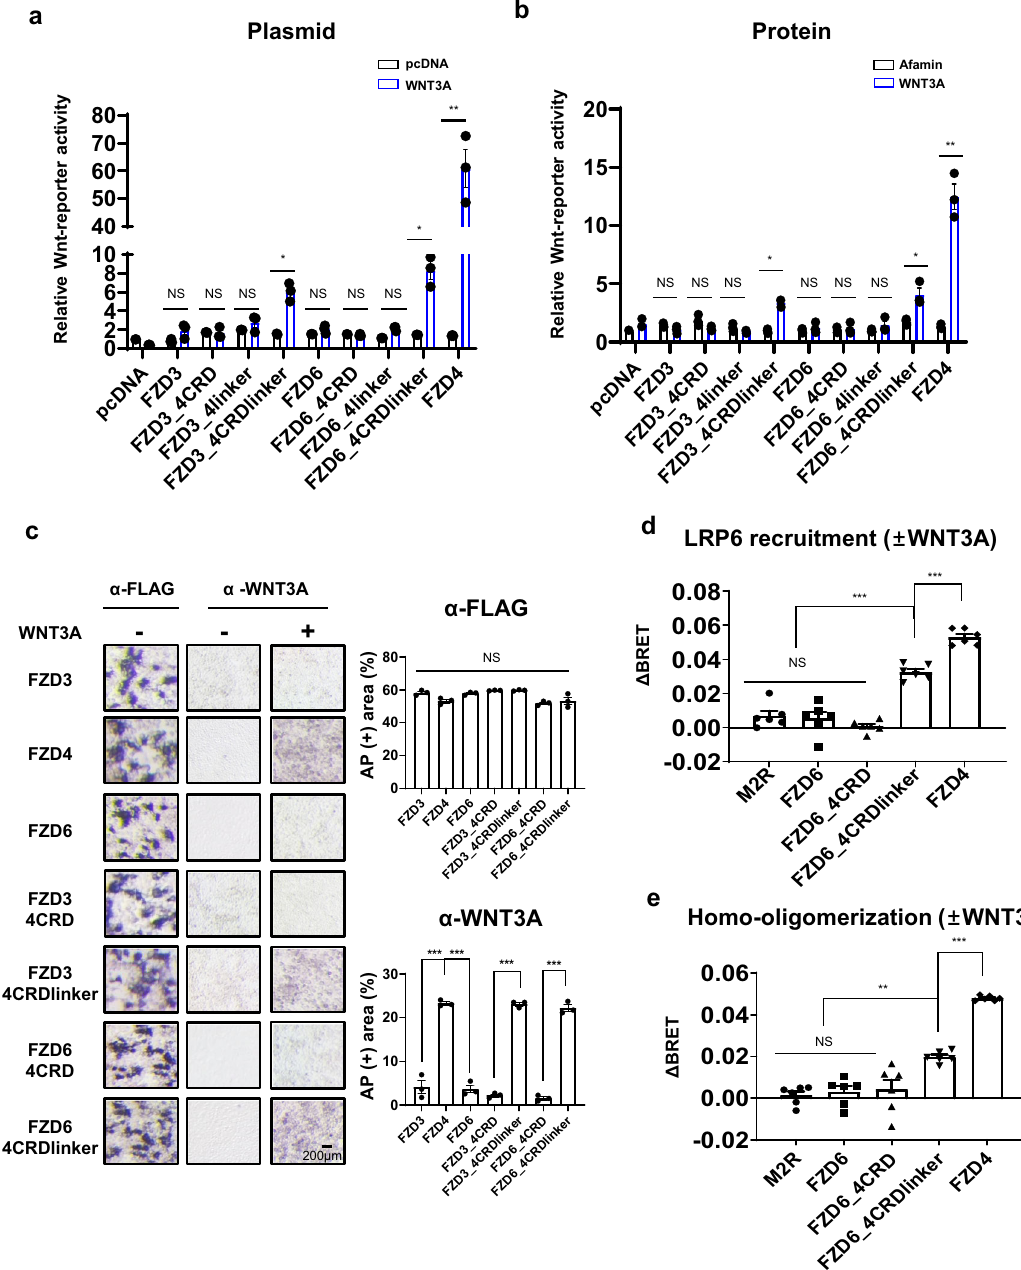
Fig. 5 Implantation of canonical FZD4 ligand-binding site in noncanonical FZD3/6. The effects of substitution of the FZD4 CRD, linker or CRDlinker into the noncanonical FZD subtype were tested with ( a ) WNT1 and WNT3A plasmid and ( b ) recombinant WNT3A protein. TOPFlash assay results are plotted as bar graphs with error bars indicating the SEM of three independent experiments. c AP staining was performed with an AP-conjugated anti-FLAG and anti-WNT3A antibodies to observe the surface expression of FZD and WNT3A bound to cells expressing indicated FZD (Scale bar: 200 µ m). The AP- stained area was measured using ImageJ and displayed as a bar graph with error bars indicating the SD of three replicates. The Δ BRET ratio was measured and calculated for ( d ) FZD-Rluc/LRP6-eYFP pair to monitor FZD-LRP6 interaction and ( e ) FZD-Rluc/FZD-eYFP pair to monitor homo-oligomerization of FZD in response to WNT3A. Error bars represent the SEM of six independent experiments. Statistical comparisons were performed using one-way ANOVA followed by the Tukey ’ s test. ‘ NS ’ represents ‘ not signi fi cant ’ , ‘ *** ’ represents P < 0.001, ‘ ** ’ represents P < 0.01, and ‘ * ’ represents P < 0.05. We investigated the binding of WNT3A to FZD3/6_4CRD and that of FZD4, perhaps due to the failure to properly recruit LRP6 FZD3/6_4CRDlinker using AP staining assays. As expected, in (Fig. 5d). Of note, in contrast to FZD4, FZD6 and its variants contrast to FZD3/6_4CRD, which failed to bind to WNT3A, showed no recruitment of LRP6 at the basal state (Supplementary FZD3/6_4CRDlinker bound to WNT3A (Fig. 5c). We did not Fig. 15). In addition, BRET signal for homo-oligomerization of observe a substantial difference in AP stain intensity between FZD6_4CRDlinker upon WNT3A treatment was much lower FZD3/6_4CRDlinker and FZD4, but the canonical signaling than that for FZD4 homo-oligomerization (Fig. 5e, Supplemen- strength of FZD3/6_4CRDlinker was insigni fi cant compared to tary Fig. 15). COMMUNICATIONS BIOLOGY| (2022) 5:421